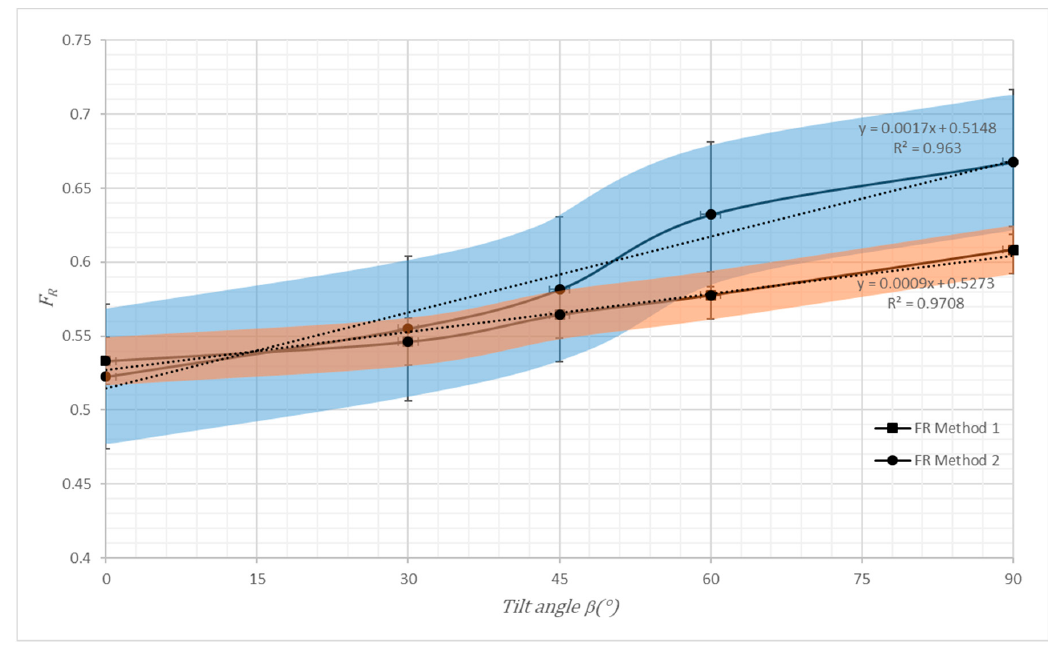
Figure 6. The F R against β by Methods 1 and 2.